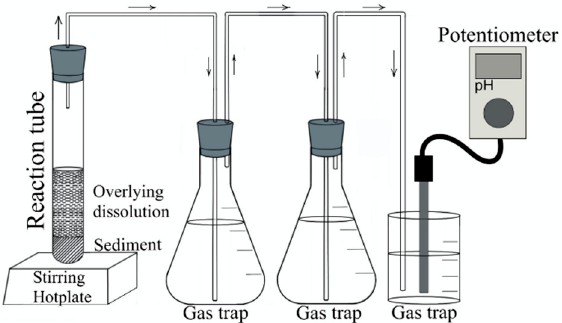
Figure 1. Experimental setup for the recovery of gold coatings from e-waste processor pins. For Batch 1, a total of 9 mL of HNO 3conc was used by adding it 1 mL at a time into the reaction tube. Once the reaction was completed, 8 mL of H 2 O DI was added (also 1 mL at a